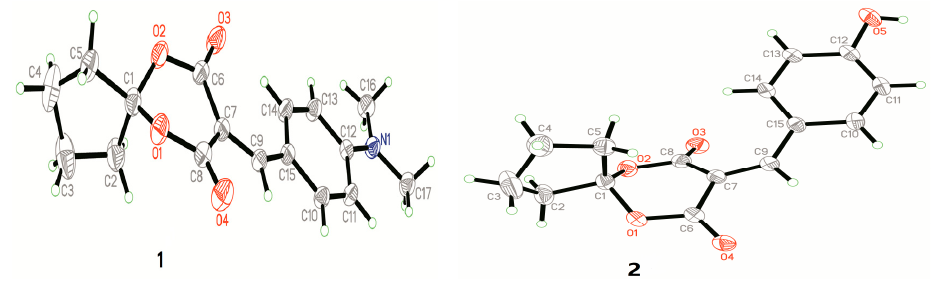
Figure 1. The molecular structures of 1 and 2 with the atomic numbering scheme.